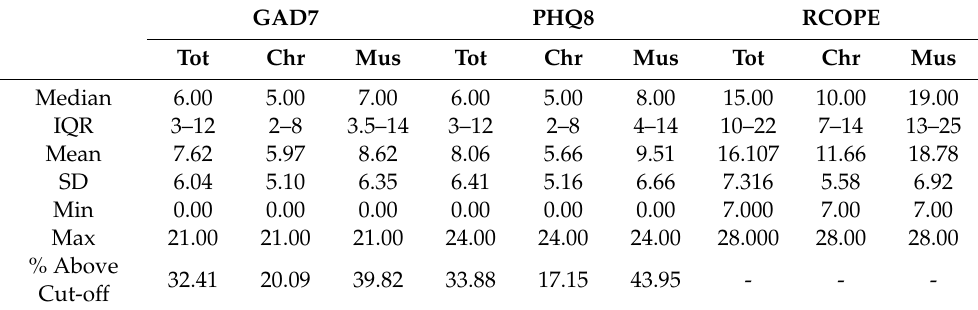
Table 2. Descriptive statistics and screening cut-o ff percentages for the study’s main variables.